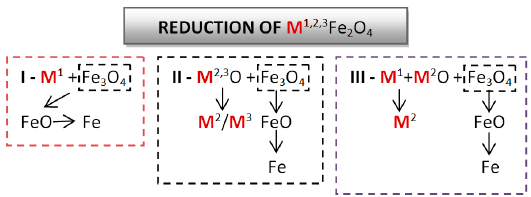
Figure 3. TPR profile of MFe 2 O 4 ferrospinels, where M = Cu, Co or Mn; α = degree of reduction (%).